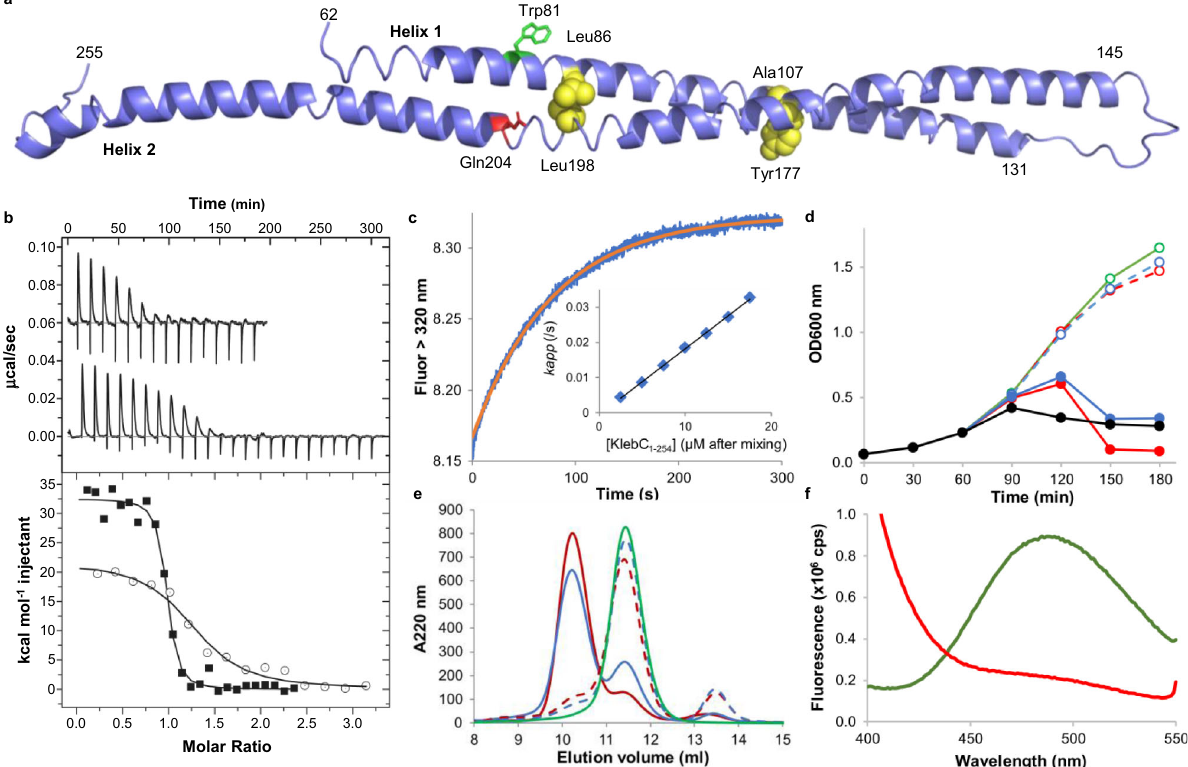
Fig. 1 Structure of the KlebC – TolC-binding domain and its binding to KqTolC. a Cartoon representation of the KlebC 51-254 TolC-binding domain crystal structure. Leu86, Ala107, Tyr177 and Leu198, mutated to form disulphide bonds are shown as yellow spheres. Side chains of FRET pair Trp81 (green sticks) and Gln204 (red sticks), which was mutated to Cys, are also shown. b ITC titration of 84 µ M KlebC 1-254 into 7.6 µ M Kq TolC ( fi lled squares) and 89 µ M KlebC 51-254 into 5.9 µ M Kq TolC (offset by 0.06 µ cal s − 1 in top panel and open circles in bottom panel). Data were fi tted to a one set of sites fi t to give K d = 35 ± 7 nM, N = 0.90 ± 0.03 binding sites per TolC trimer and Δ H 30.6 ± 2.6 kcal mol − 1 and K d = 368 ± 16 nM, N = 1.34 ± 0.12 binding sites per TolC trimer and Δ H 20.8 ± 1.0 kcal mol − 1 for KlebC 1-254 and KlebC 51-254 , respectively. Typical traces are shown, values are averages of duplicate experiments. c Pre- equilibrium fl uorescence increase in tryptophan emission upon complex formation between 0.5 µ M Kq TolC and 7.5 µ M KlebC 1-254 . Single exponential fi t to the data to determine k app is shown in red. Inset, Dependence of k app on KlebC 1-254 concentration. Data are averages of duplicate experiments fi tted to a straight line, the gradient of which gives the association rate constant, 1.9 ± 0.1 × 10 3 M − 1 s − 1 . d Liquid growth curves of K. quasipneumoniae Qmp M1-977, with the addition of KlebC-E9 DNase (black), A107C, Y177C KlebC-E9 DNase (reduced, solid red; oxidised, dashed red), L86C, L198C KlebC-E9 DNase (reduced, solid blue; oxidised, dashed blue), or no KlebC-E9 DNase (green), added after 60 min. Data shown are from one representative experiment out of three biological repeats. e In total, 200 µ l Kq TolC (green), Kq TolC + L86C, L198C KlebC 1-254 (reduced, solid blue; oxidised, dashed blue), and Kq TolC + A107C, Y177C KlebC 1-254 (reduced, solid red; oxidised, dashed red) were loaded onto a 10/300 S200 column. f Fluorescence emission of 1 µ M Q204C AEDANS KlebC 1-254 in the absence (green) and presence (red) of 1 µ M Kq TolC. λ Ex = 280 nm, slit widths = 2